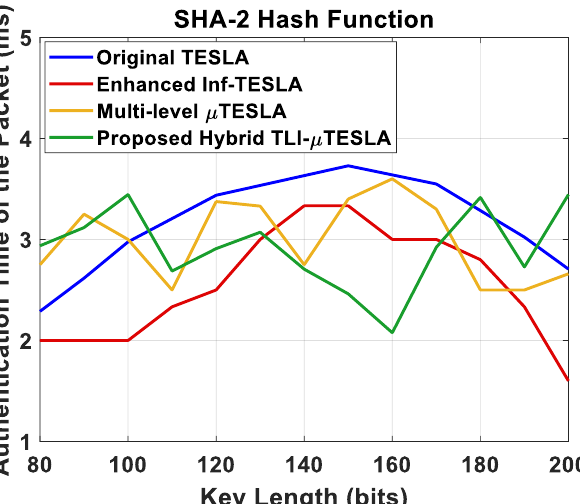
Figure 10. Simulation results of the original TESLA protocol (blue line), enhanced Inf-TESLA pro- tocol (red line), Multilevel-µTESLA protocol (yellow line), and Proposed Hybrid TLI-µTESLA pro- tocol (green line), demonstrating the authentication time of the low-level (message) packets with the change in the key size using SHA-2 hash function.